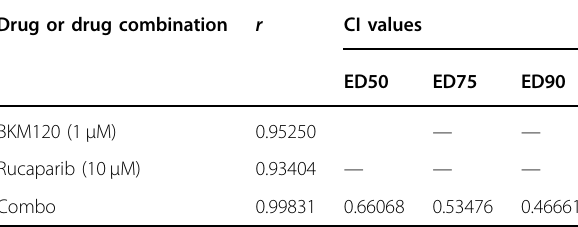
Table 2 Combination indexes (CI) of BKM120 and Rucaparib in U87MG cells.